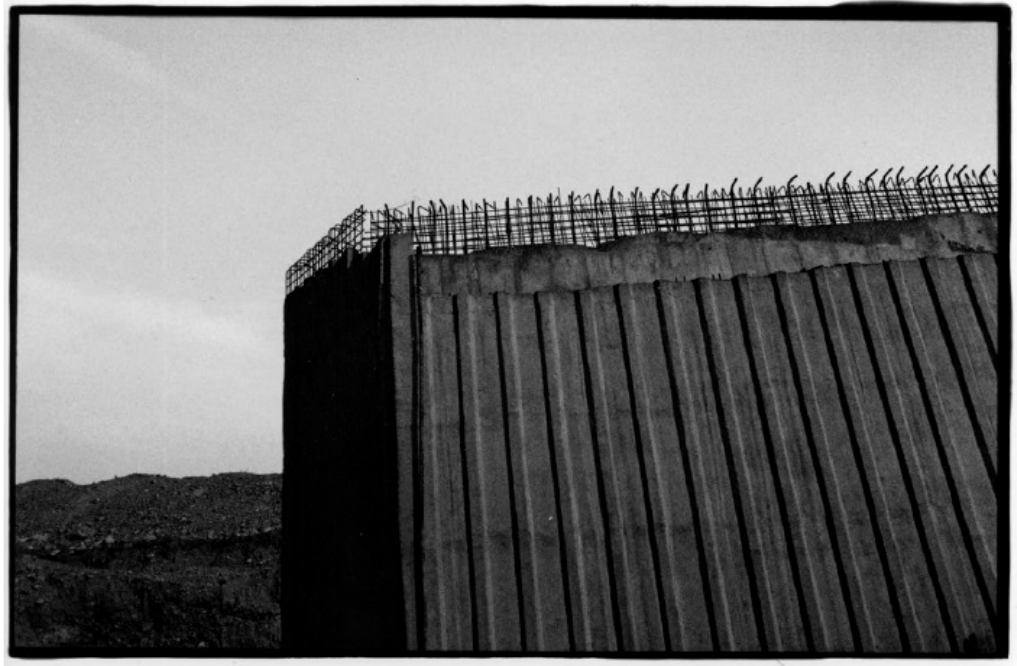
Figure 10. Mohammad Ghazali, from the Persepolis 2560–2580 series, Lost no. 023, 2001–2021, Analog photography, gelatine silver print, 13.5 × 20.5 cm.